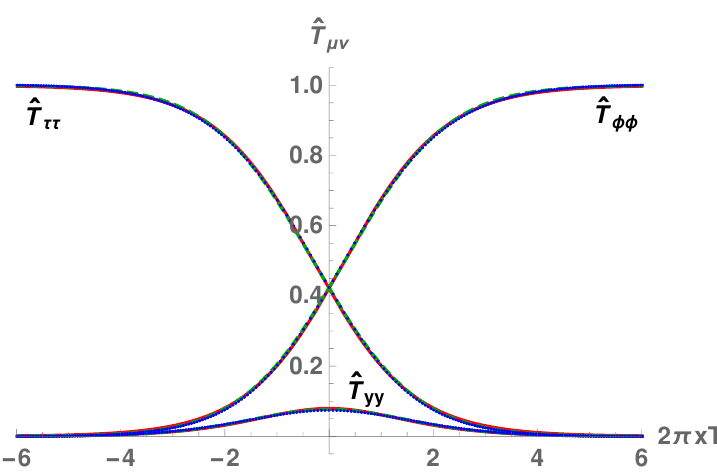
Figure 10 . Final fits of the model to the numerical solution for the domain wall for d = 4 . The blue dots, solid red curve, and dashed green curve show the numerical data, fit using the option A, and fit using the option B,